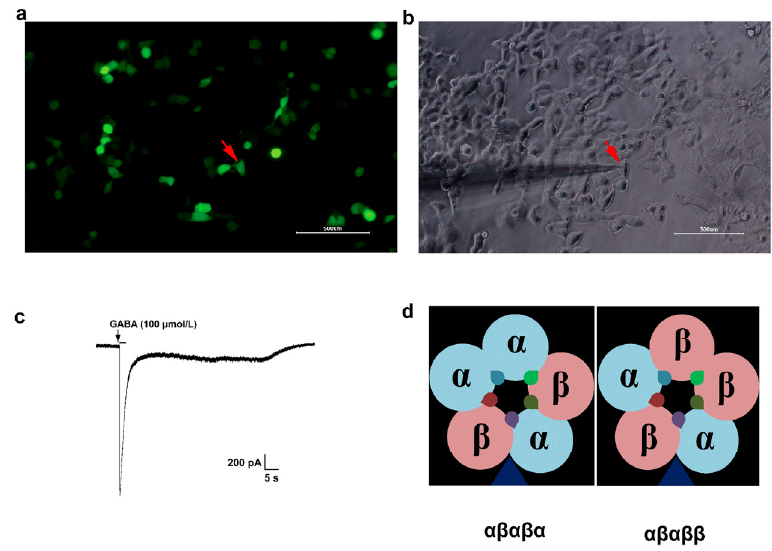
Figure 1. Expression of αβ receptors in HEK293 cells. HEK293 cells were co-transfected with cDNAs of different α and β /EGFP in a ratio of 1:1, cells showed green fluoresce 48 h after transfection ( a ). EGFP-positive cells were subjected to whole-cell voltage-clamp electrophysiology with a holding potential of − 60 mV, red arrowheads indicated the patched cell ( b ). GABA evoked currents when applied to the patched cell ( c ). ( d ) α and β subunits can assembled in two stoichiometries of three α subunits with two β subunits ( αβαβα ) or two α subunits with three β subunits ( αβαββ ), represents the possible benzodiazepine binding sites. Table 1. Effects of GABA and benzodiazepines on αβ receptors.